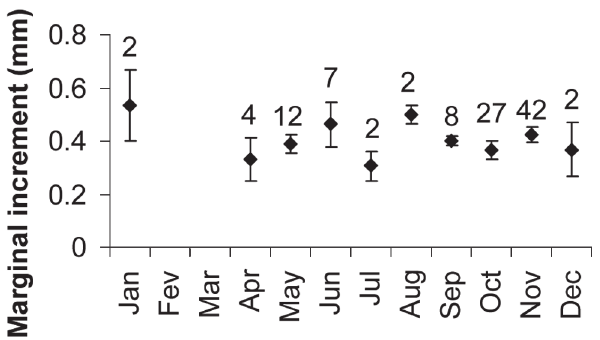
Fig. 6. Monthly measures of the marginal increment in the otoliths of the dog snapper Lutjanus jocu for the year 2006 in Abrolhos Bank. The numbers represent the sample size.